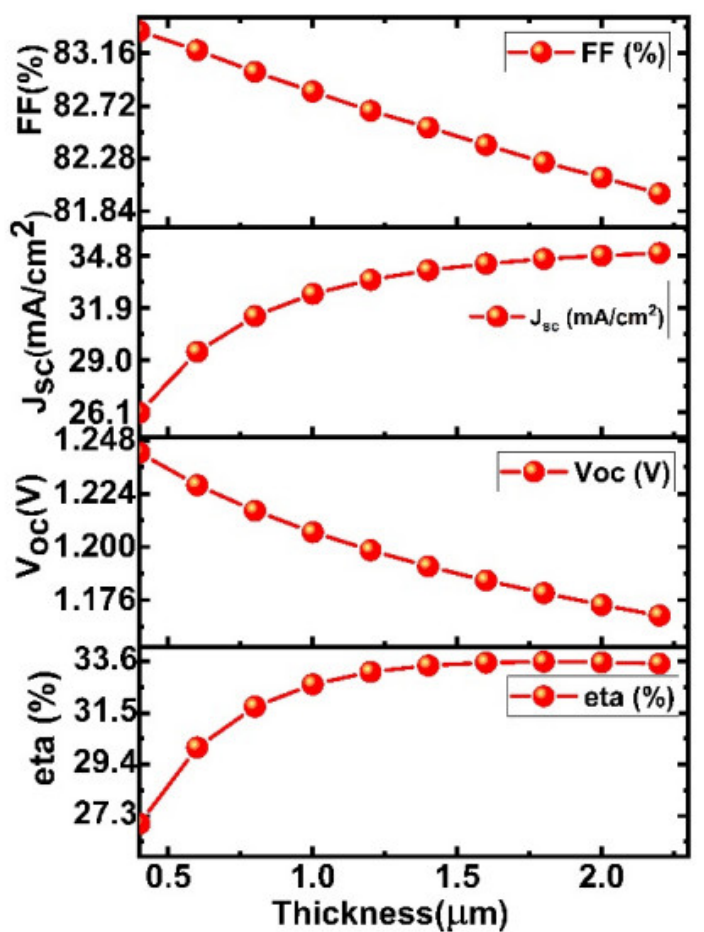
Figure 7. The effect of the perovskite layer thickness on solar cell parameters [144].